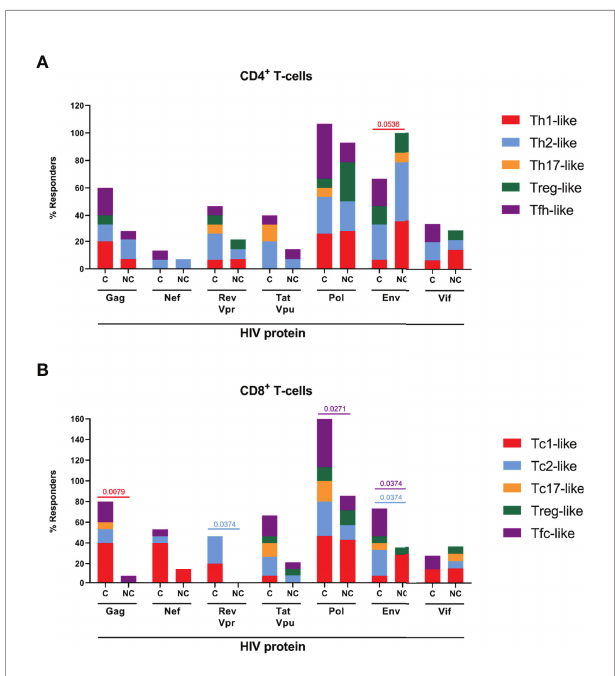
FIGURE 2 | HIV protein-speci fi c polarized T-cell responses. Boosted Flow screening of HIV protein-speci fi c T-cell responses resulted into protein-dependent different polarized pro fi les in both CD4+ T-cells and CD8+ T-cells. The percentage of responders to each of the HIV-1 derived proteins is indicated in stacked bars for CD4+ (A) and CD8+ (B) T-cells. Statistically signi fi cant (p<O.O5) differences in protein-speci fi c frequency of response between HIV+ controllers (C) and HIV+ non-controllers (NC) are indicated. Statistical signi fi cance was evaluated by Chi-